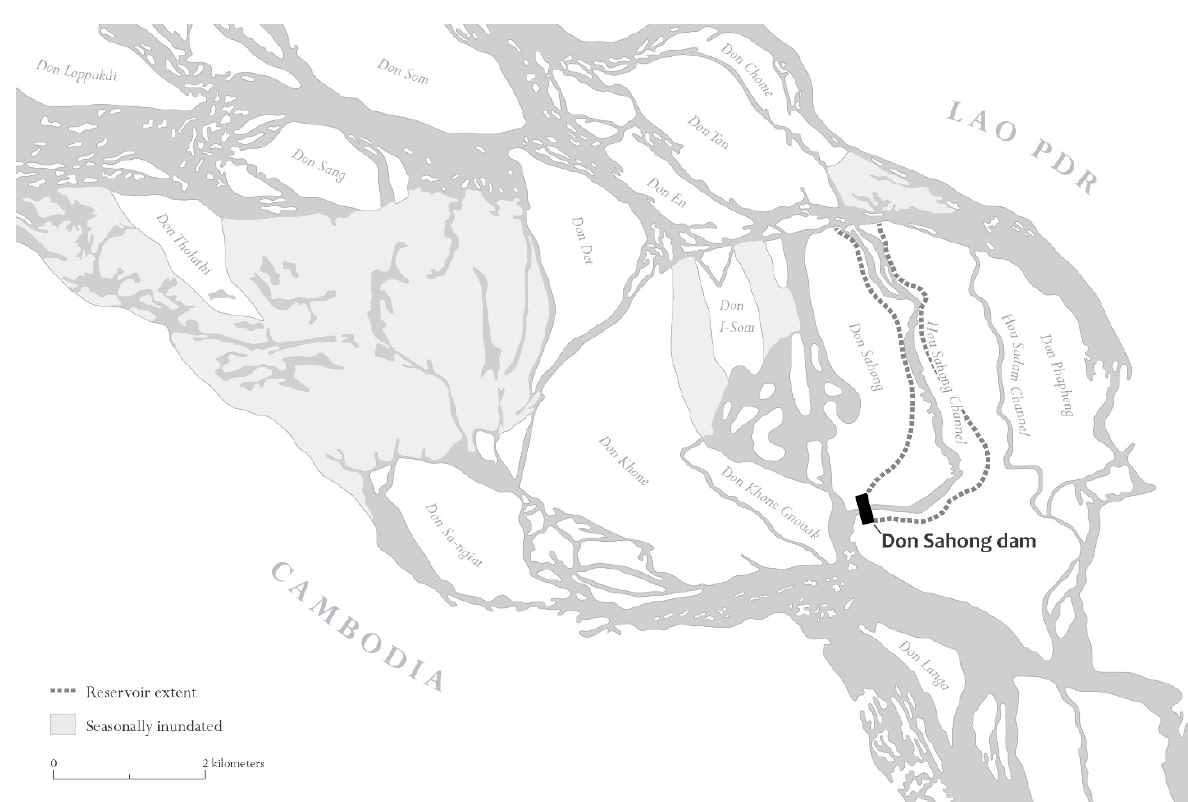
Figure 2. The Khone Falls area, including the Don Sahong Dam, in southern Laos near the border with Cambodia.